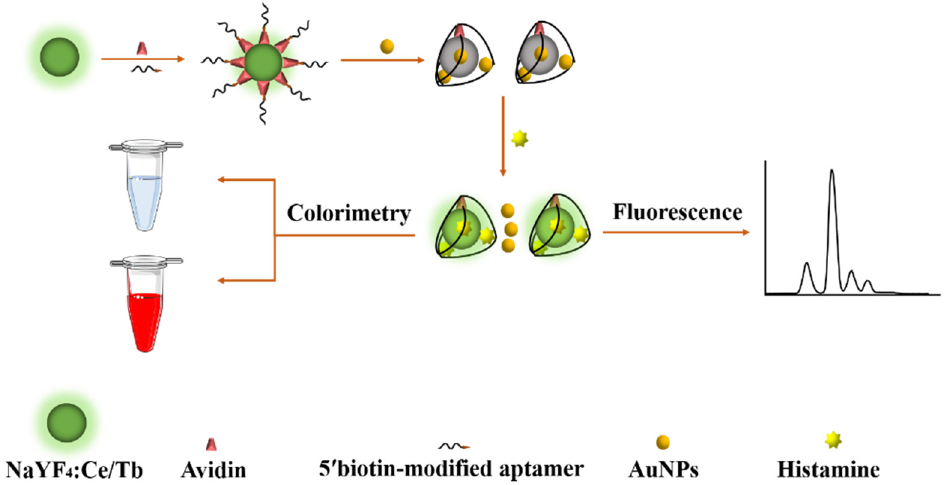
Figure 5. Schematic diagram of histamine detection based on the aptamer/AuNPs fluorometric and colorimetric dual-mode detection.